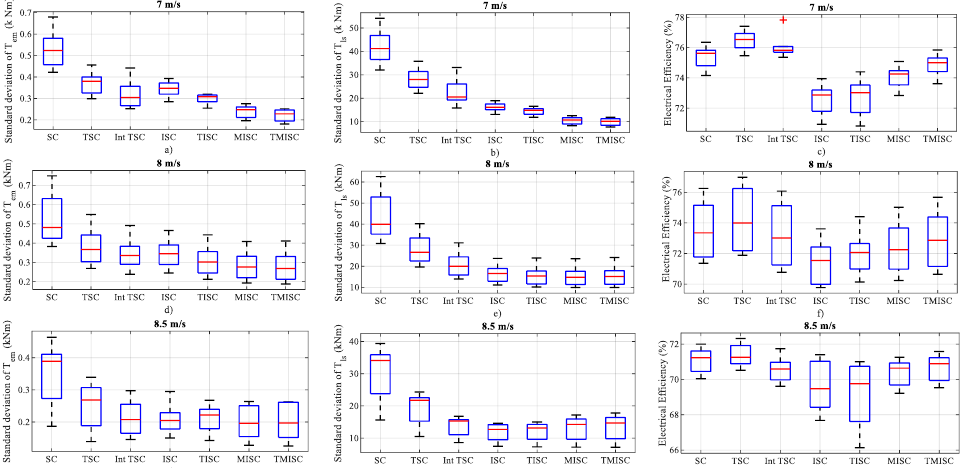
Figure 10. Performance of the controllers for different spectral models and mean wind speed profiles. ( a ) STD of T em at 7 m/s ( b ) STD of T ls at 7 m/s ( c ) Electrical efficiency at 7 m/s ( d ) STD of T em at 8 m/s ( e ) STD of T ls at 8 m/s ( f ) Electrical efficiency at 8 m/s ( g ) STD of T em at 8.5 m/s ( h ) STD of T ls at 8.5 m/s and ( i ) Electrical efficiency at 8.5